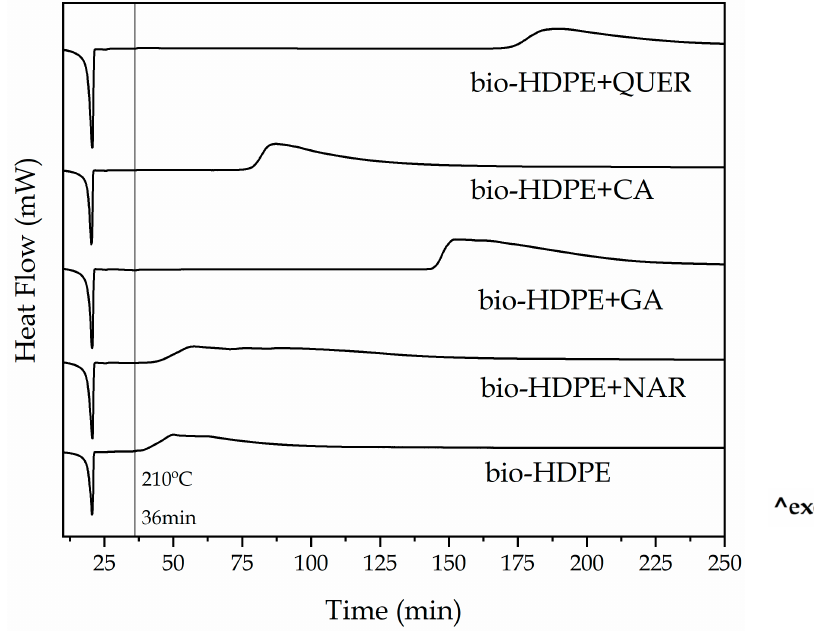
Figure 8. Isothermal curves obtained by differential scanning calorimetry (DSC) of the thermo- compressed bio-based high-density polyethylene (bio-HDPE) films containing naringin (NAR), gallic acid (GA), caffeic acid (CA), and quercetin (QUER).